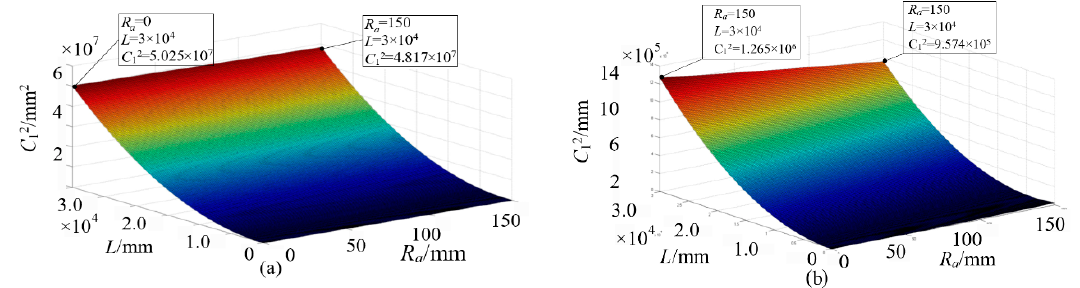
Figure 7. Change surface map of C 1 . ( a ) corresponds to the same positive and negative α r and γ r , ( b ) corresponds to the difference between α r and γ r .